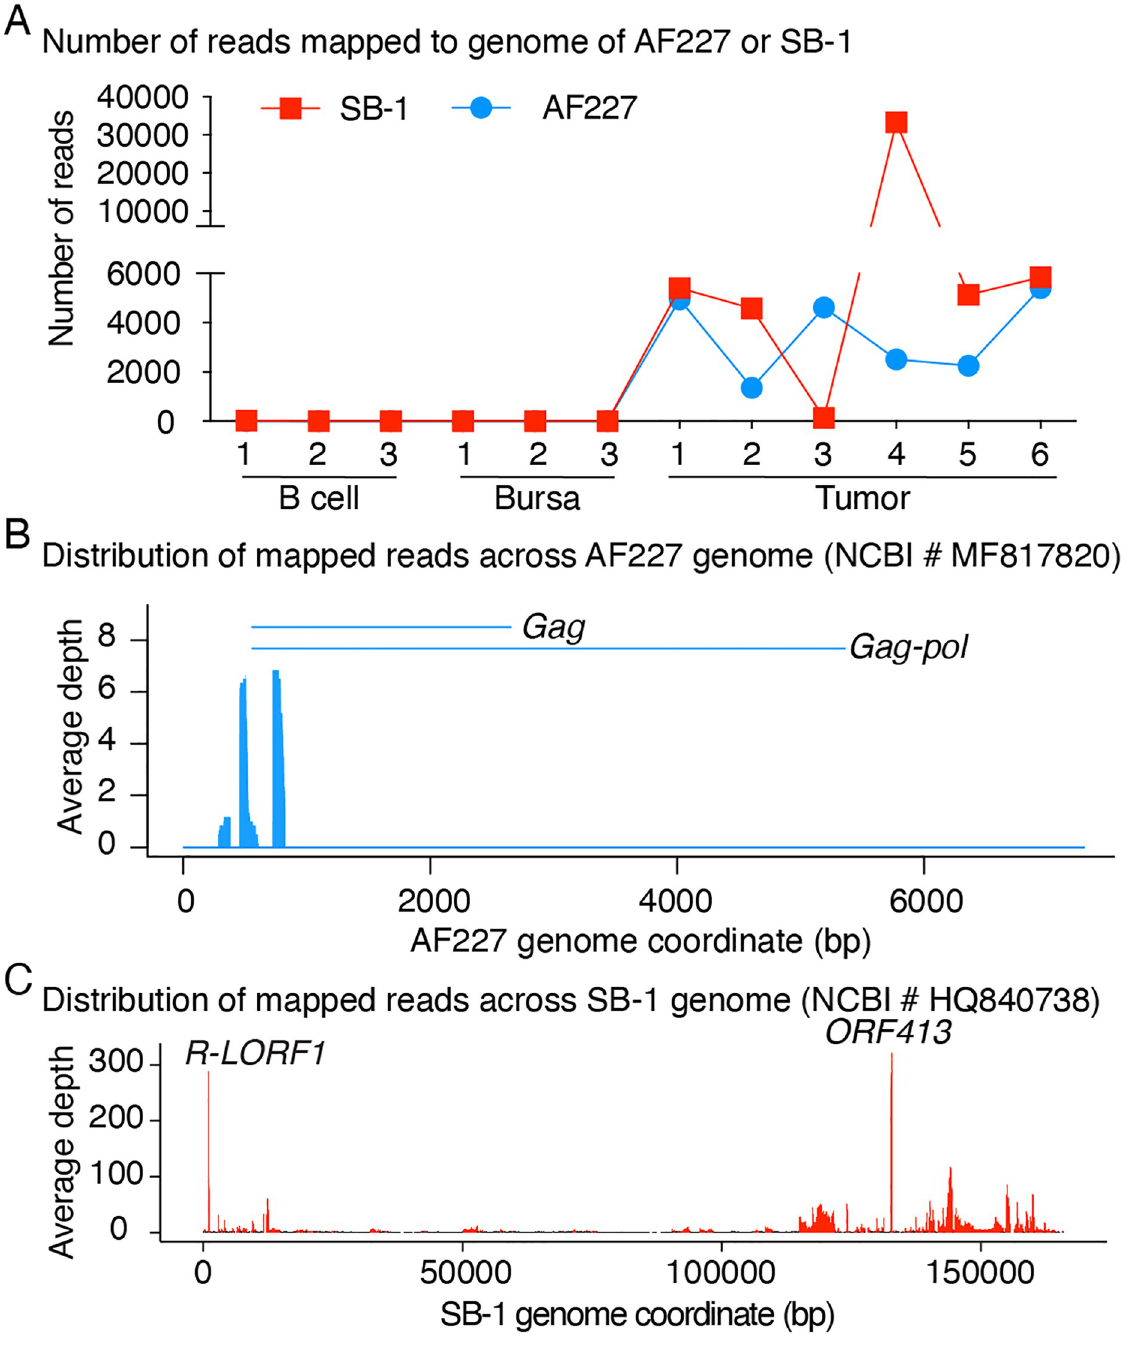
Fig 1. RNA-seq reads mapped to genomes of AF227 and SB-1 viruses. (A) Clean RNA-seq reads that failed mapping to the chicken reference genome were further mapped to the genomes of AF227 (NCBI # MF817820) and/or SB-1 (NCBI # HQ840738) viruses. The total number of mapped reads were counted for each virus in each sample. (B) Distribution of mapped reads of the LL-like tumor samples across the genome of AF227 and (C) SB-1 virus. The Y axis indicates the average depth of each location of the six tumor samples.